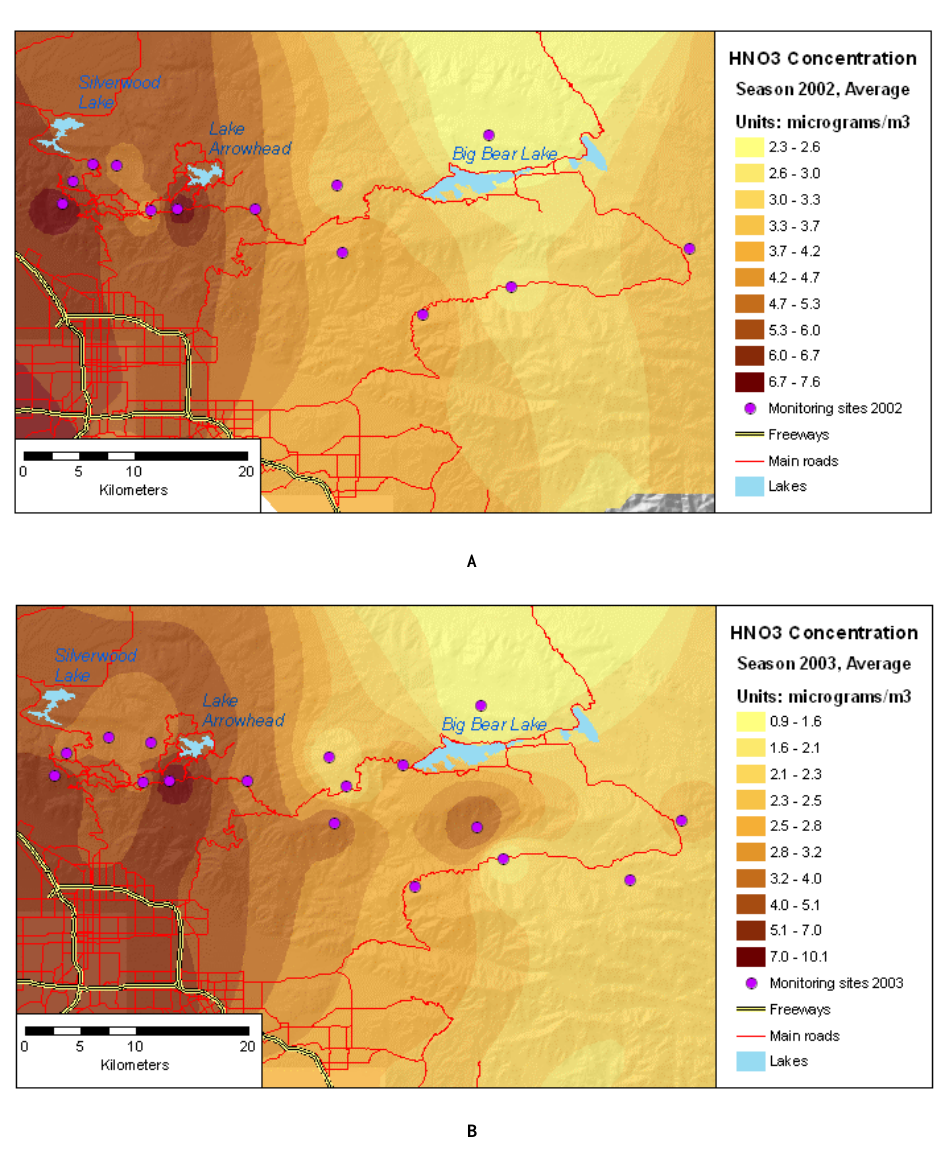
FIGURE 4 . Distribution of HNO 3 concentrations determined with passive samplers in the SBM; (A) 2002, (B) 2003, (C) 2004, and (D)